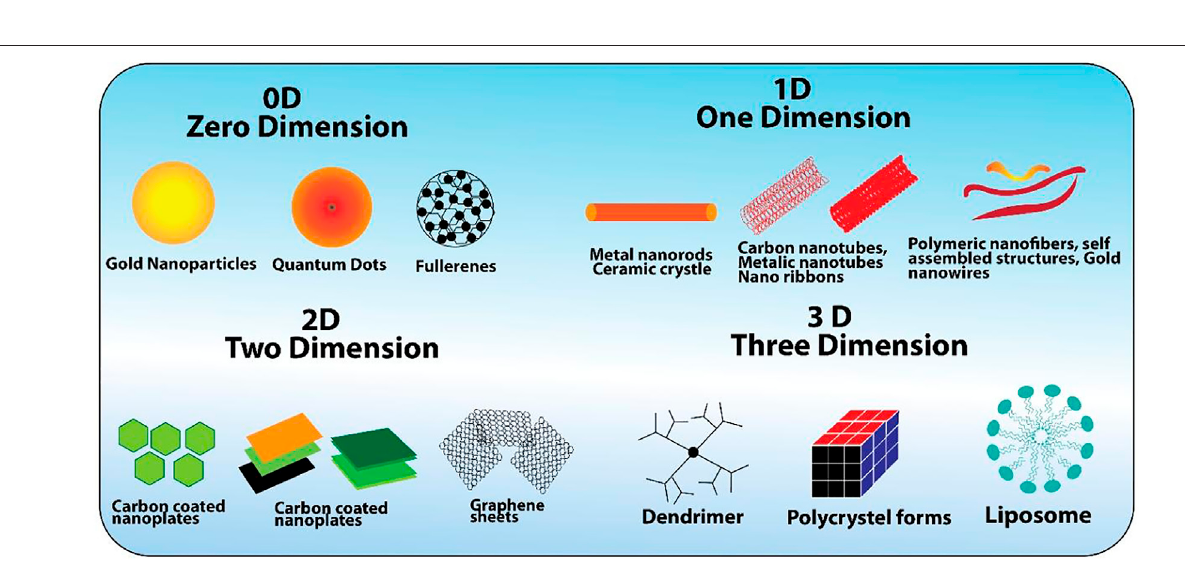
Frontiers in Bioengineering and Biotechnology |